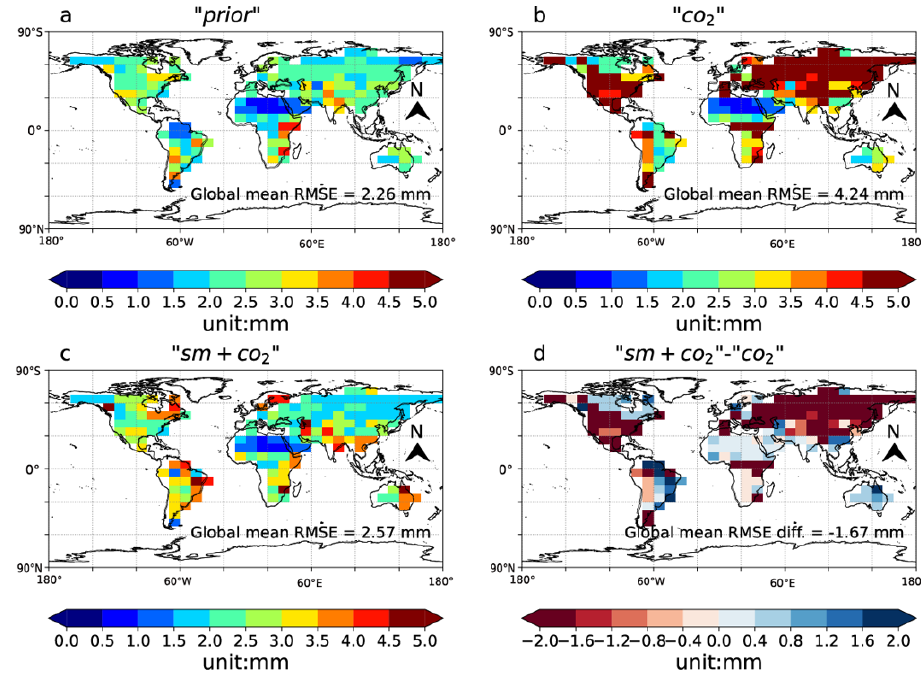
Figure 2. Comparisons of RMSE of monthly soil moisture from the ( a ) “ prior ”, ( b ) “ co 2 ” , and ( c ) “ sm + co 2 ” experiments against ESA -CCI soil moisture, as well as ( d ) the difference between “ sm + co 2 ” and “ co 2 ”. Values in each figure denote the global mean RMSE values in “ prior ”, “ co 2 ” , and “ sm + co 2 ” experiments.